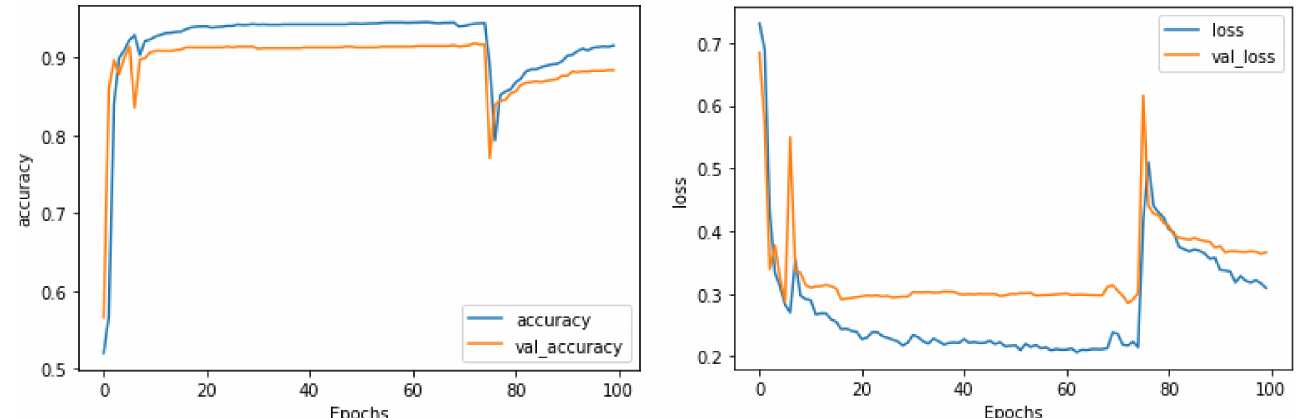
Figure 11. The data training process using CNN.